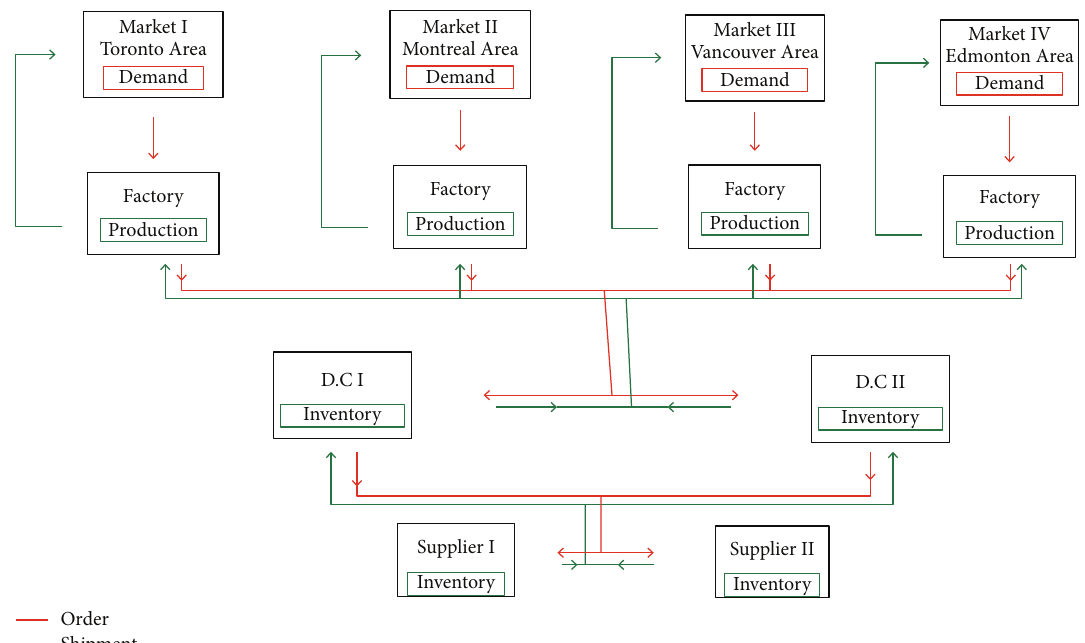
Figure 1: The lobster supply